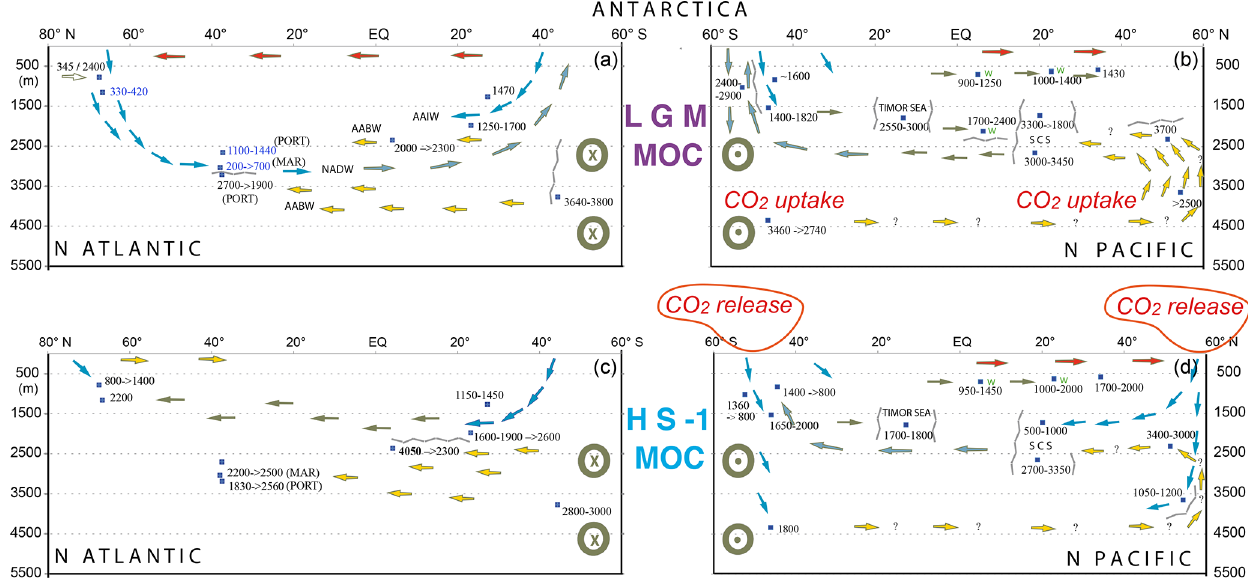
Figure 10. The 2D transects of the geometries of global ocean MOC. Arrows (blue is high ventilation, and yellow is poor ventilation) suggest average deep and intermediate water currents that follow the gradient from low to high benthic ventilation ages based on paired planktic 14 C reservoir ages derived by means of a 14 C plateau tuning technique (Sarnthein et al., 2013; Balmer et al., 2018; Küssner et al., 2020a). At some Pacific sites reservoir ages are based on paired 14 C ages of planktic foraminifera and wood chunks (marked by a green “w”; Sarnthein et al., 2015; Zhao and Keigwin, 2018; Rafter et al., 2018). Red arrows suggest poleward warm surface water currents. Zigzagging lines indicate major frontal systems separating counter rotating ocean currents (e.g., west of Portugal and north of MD07-307; following Skinner et al., 2014). (a, b) Late LGM circulation geometry (21–18.7calka) that is largely similar to today. Note the major east–west gradient of ventilation ages in the central North Atlantic between Portugal (PORT) and the Mid-Atlantic Ridge west of the Azores (MAR). (c, d) HS-1 benthic ventilation ages reveal a short-lasting MOC reversal leading to Atlantic-style overturning in the subpolar North Pacific and coeval Pacific-style stratification in the northern North Atlantic, with seesaw-style reversals of global MOC at the onset and end of early HS-1 (first proposed by Broecker et al., 1985, albeit for LGM times). Increased ventilation ages reflect enhanced uptake of dissolved carbon in the LGM deep ocean (Sarnthein et al., 2013), major drops suggest major degassing of CO 2 from both the deep Southern Ocean and North Pacific during early HS-1. SCS is the South China Sea. AABW is Antarctic Bottom Water. AAIW is Antarctic Intermediate Water. NADW is North Atlantic Deep Water. Small arrows within age numbers reflect temporal trends. Many arrows are speculative, using circumstantial evidence of benthic δ 13 C records and local Coriolis forcing at high-latitude sites per analogy to modern scenarios. Location of sediment cores are given in Fig. 7, and short-term variations in planktic and benthic 14 C reservoir and ventilation age are given in Fig. S2 and Table